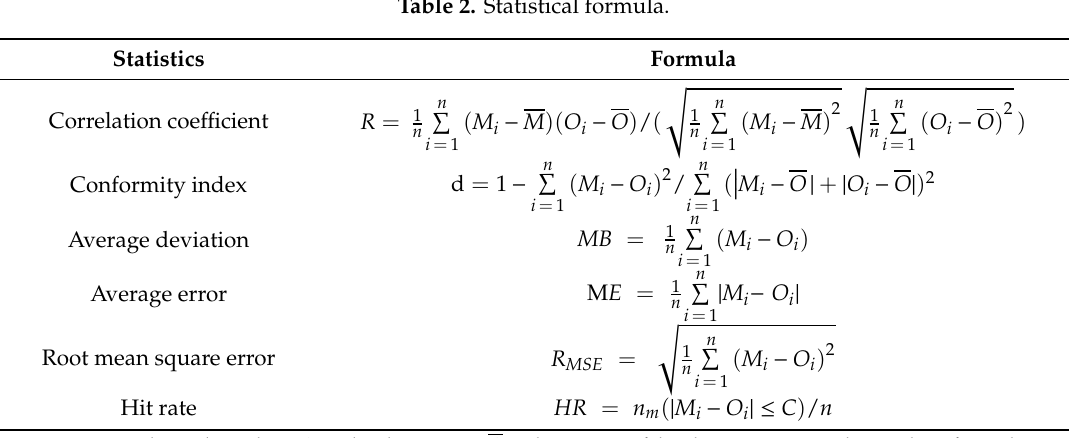
Table 2. Statistical formula.